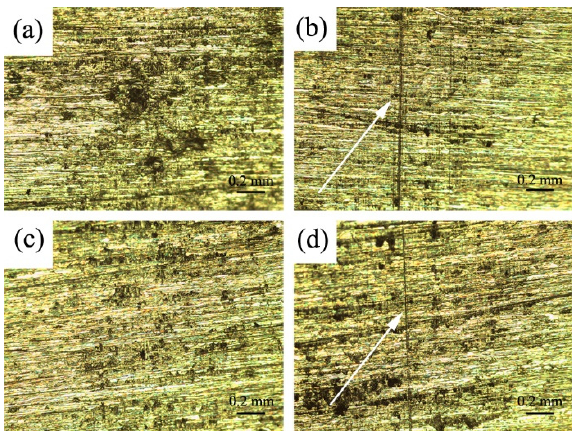
Figure 9. Surface morphologies of the OSERs on iron substrates after pencil hardness test. ( a ) DETA-OSER, scratched with an 8H pencil. ( b ) DETA-OSER, scratched with a 9H pencil. ( c ) MXDA-OSER, scratched with an 8H pencil. ( d ) MXDA-OSER, scratched with a 9H